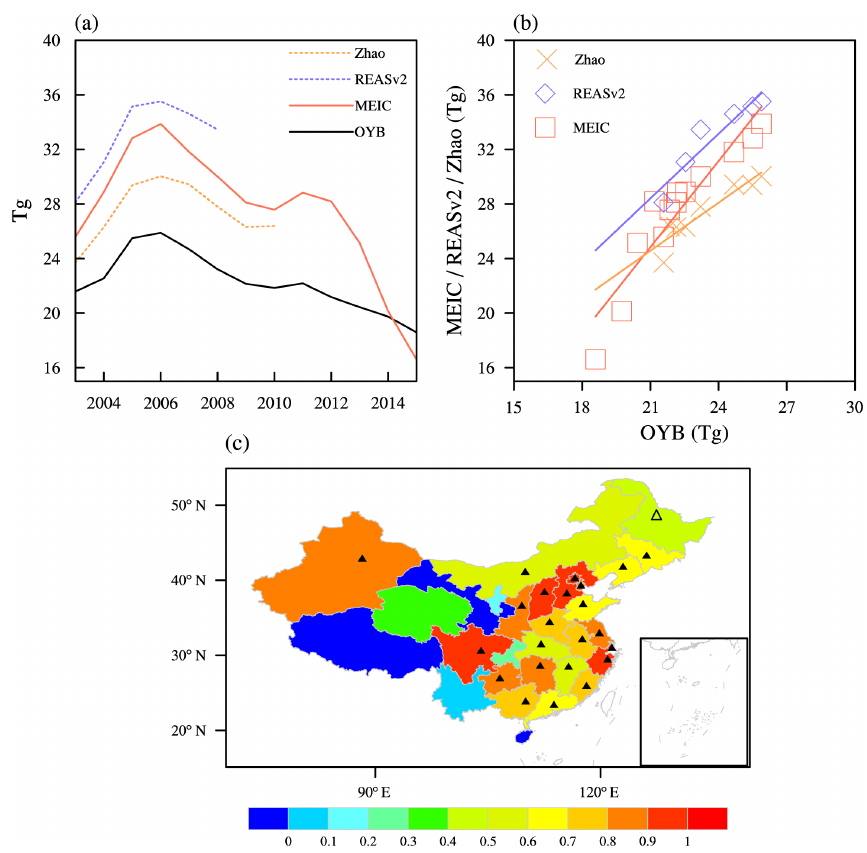
Figure 1. (a) National total SO 2 emissions estimated by OYB (solid black), MEIC (solid red), REAS (dashed blue) and Zhao (dashed orange) between 2003 and 2015. (b) Scatter diagrams and regression lines for the OYB estimate ( x axis) against the other three products ( y axis). (c) The province-by-province correlations between the OYB and MEIC products, with the significance levels of 0.1 and 0.05 being marked by open and filled triangles,